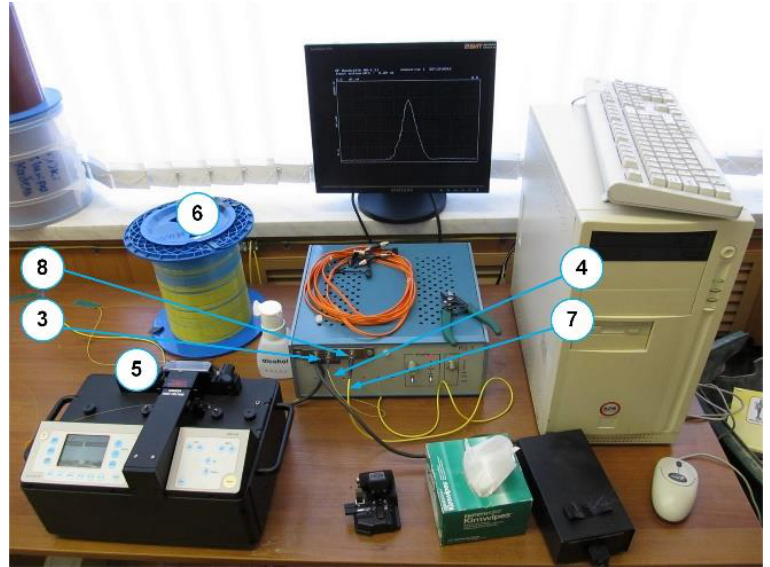
Figure 12. General view of DMD analyzer workstation R2D2: “3” is “Tx” fiber optic adaptor FC; “4” is “Tx” pigtail FC/PC; “5” is fusion splicer (offset connection of “Tx” pigtail and tested optical fiber); “6” is tested optical fiber; “7” is “Rx” pigtail FC/PC; and “8” is “Rx” fiber optic adaptor FC.